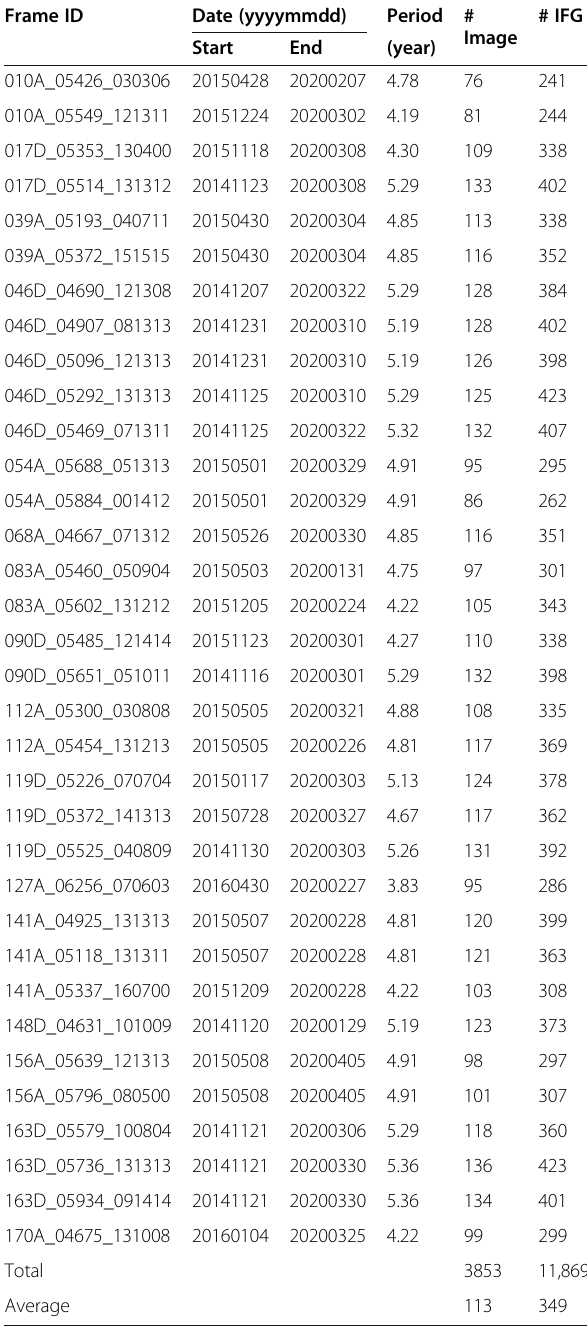
Table 1 LiCSAR frames, observation periods, and number of data used in this